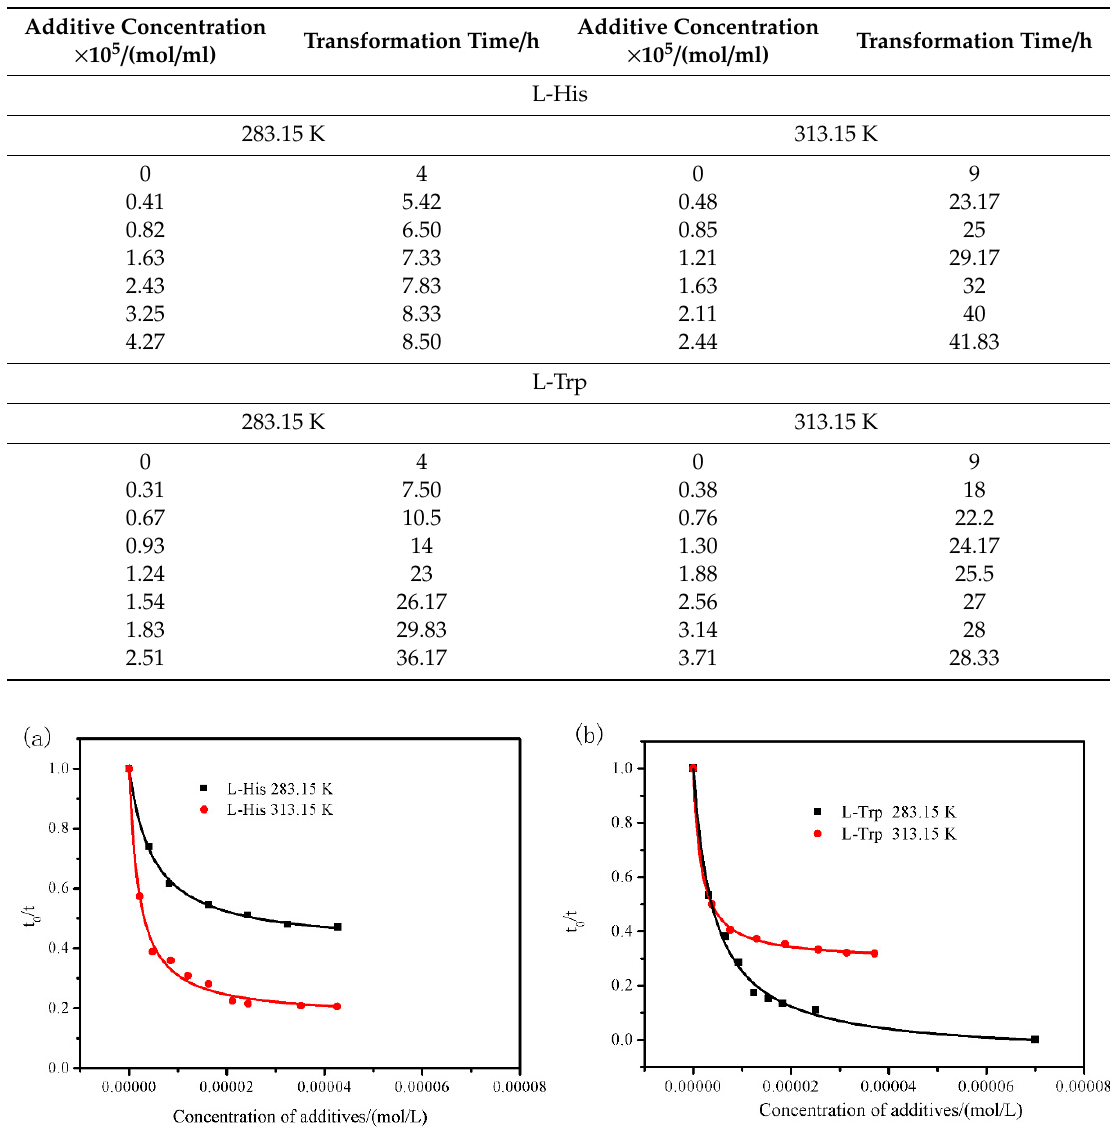
Figure 6. Fitting of the L-Phe transformation behavior data fitting in the presence of additive ( a ) L-His and ( b ) L-Trp at temperature 283.15 K and 313.15 K in pure water using the Langmuir model. Table 5. The parameters of the Langmuir Table 4. Effect of additive concentration on the transformation behavior of L-Phenylalanine.